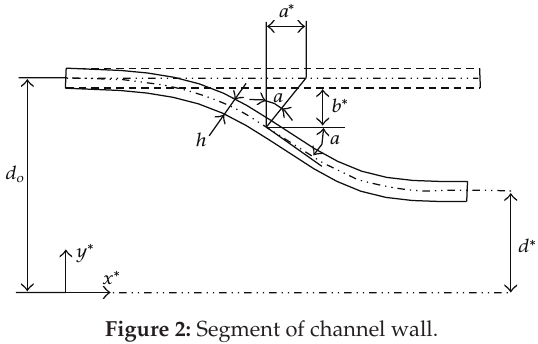
Figure 2: Segment of channel